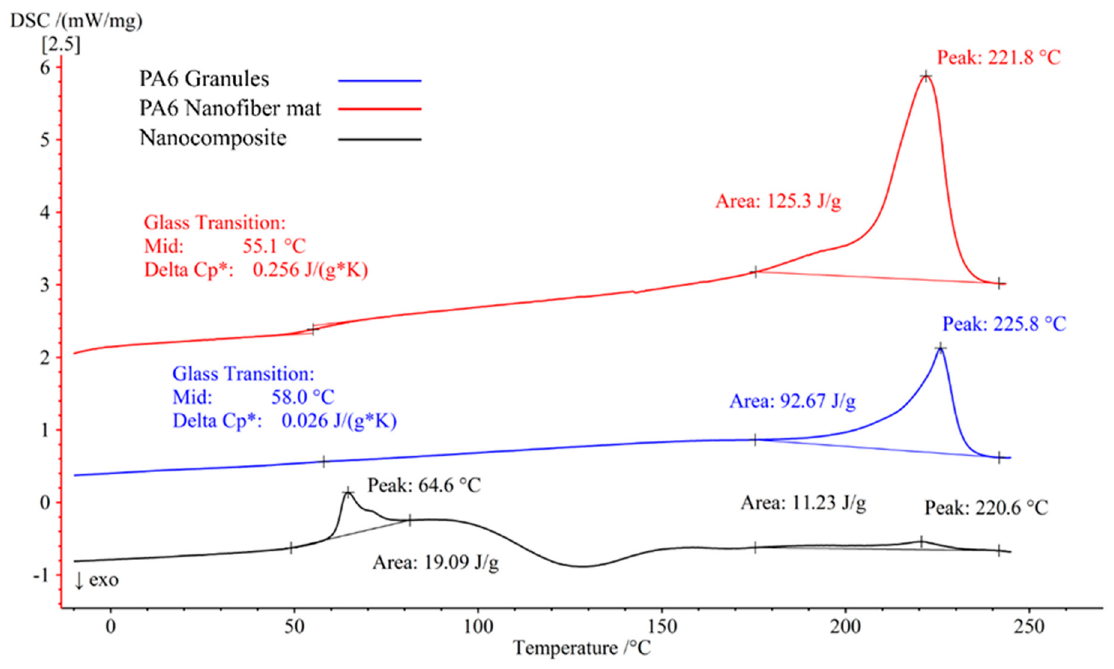
Figure 9. Differential scanning calorimetry (DSC) of the PA6 granules, PA6 nanofiber mats, and the